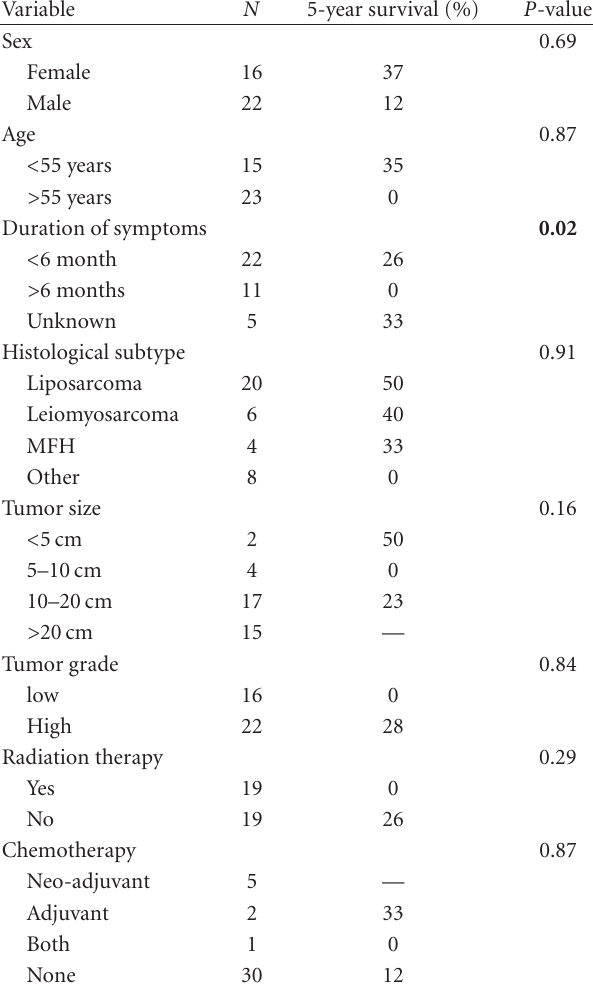
Table 4: Univariate analysis of prognostic factors for disease-free survival in 38 patients who underwent complete resection of their primary retroperitoneal